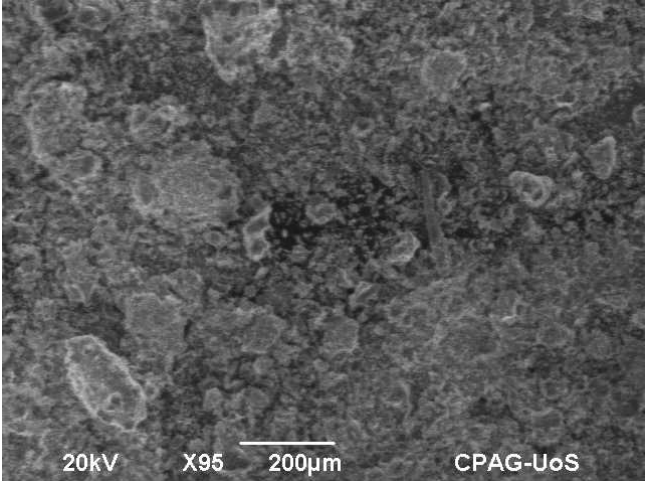
Figure 2. Scanning Electron Microscopy (SEM) image at × 95 maginification (20 kV; 200 µm; 800 °C—2 h) of RHA particles.